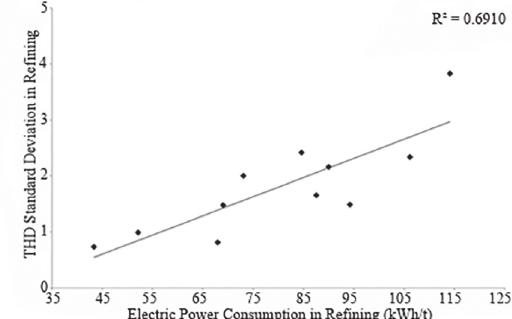
Figure 9: Electric power consumption in the refining and THD standard deviation.